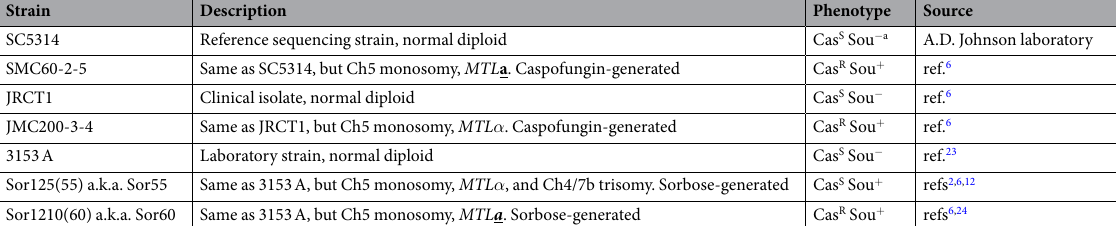
Table 1. C. albicans strains used in this study. a The majority of C. albicans strains do not utilize sorbose. However, monosomy of Ch5 confers sorbose utilization or the Sou + phenotype. Caspofungin susceptibility of JMC200-3-4 or SMC60-2-5 was determined with spot assay and with standard broth microdilution method 13 , while Sor1210(60) or Sor125(55) were spot assayed 6 . Note that Sor125(55) is more susceptible to caspofungin than its parental strain 3153 A 6